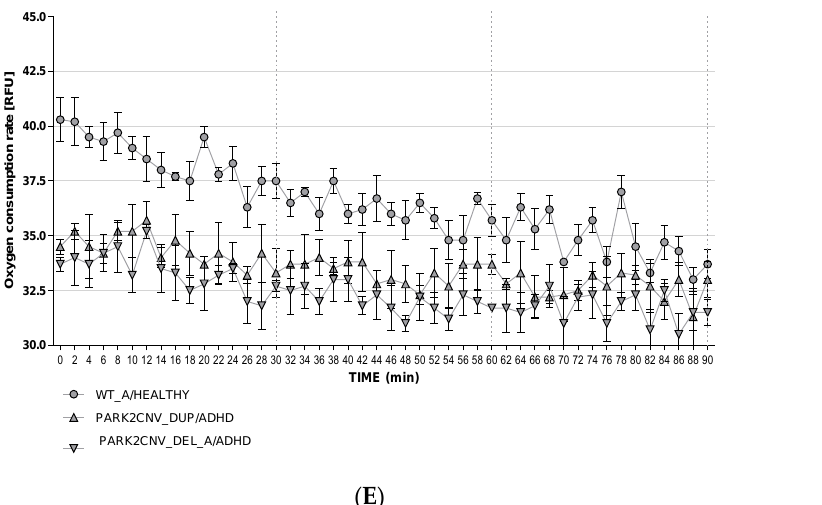
Figure 4. ( A – F ): Oxygen consumption rate in human-derived fibroblasts (HDF). Basal oxygen consumption was measured under baseline ( A , D ), starvation ( B , E ), and CCCP treatment conditions ( C , F ). Fluorescence (RFU- y -axis) signal correlating with the respiration was recorded every two minutes for 90 min. Data are presented as mean of two independent experiments with samples measured in triplicate. Figure 4A–C show a combined analysis of PARK2 CNV deletion + duplication vs. wildtype healthy+ADHD wildtype to increase number of HDF cell lines and statistical power). HDF derived from ADHD patients carrying PARK2 CNVs showed lower rates of extracellular oxygen consumptions compared to WT in all the intervals both under baseline conditions (I 0–30 : CNV carriers (M = 36.056; SD = 0.106), WT (M = 38.493; SD = 1.276); I 30–60 : CNV carriers (M = 35.026; SD = 0.068), WT (M = 37.859; SD = 1.209); I 60–90 : CNV carriers (M = 34.841; SD = 0.293), WT (M = 37.626; SD = 1.279) (see Figure 4A) and after starvation (I 0–30 : CNV carriers (M = 34.938; SD = 1.267 ), WT (M = 39.160; SD = 1.398); I 30–60 : CNV carriers (M = 33.907; SD = 1.296), WT (M = 36.970; SD = 1.527); I 60–90 : CNV carriers (M = 33.593; SD = 1.427), WT (M = 35.430; SD = 1.265). Figure 4D–F shows the data of HDF cell lines from PARK2 CNV duplication vs. deletion vs. wildtype healthy control separately. There was a significant di ff erence between the genotypes in all intervals in baseline: